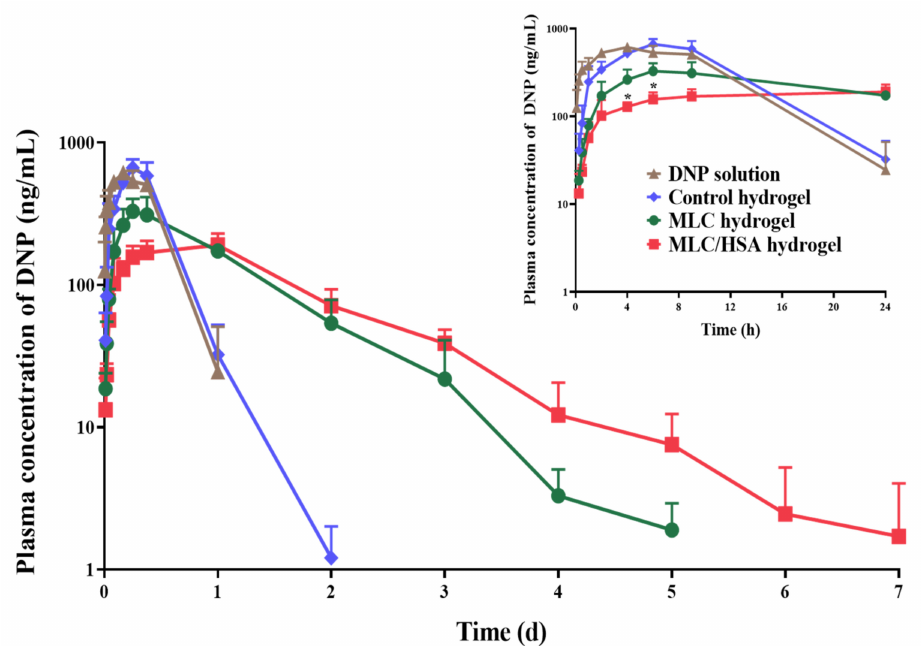
Figure 6. Time-dependent plasma concentration profiles of DNP after the subcutaneous injection of the developed hydrogels (10 mg/kg as DNP) in rats. The insert shows the profiles up to 24 h. Each point represents the mean ± SD ( n = 4); * p < 0.05 (compared to the MLC hydrogel). Table 3. Pharmacokinetic parameters of DNP after the subcutaneous injection (10 mg/kg as DNP) in rats. Parameter DNP